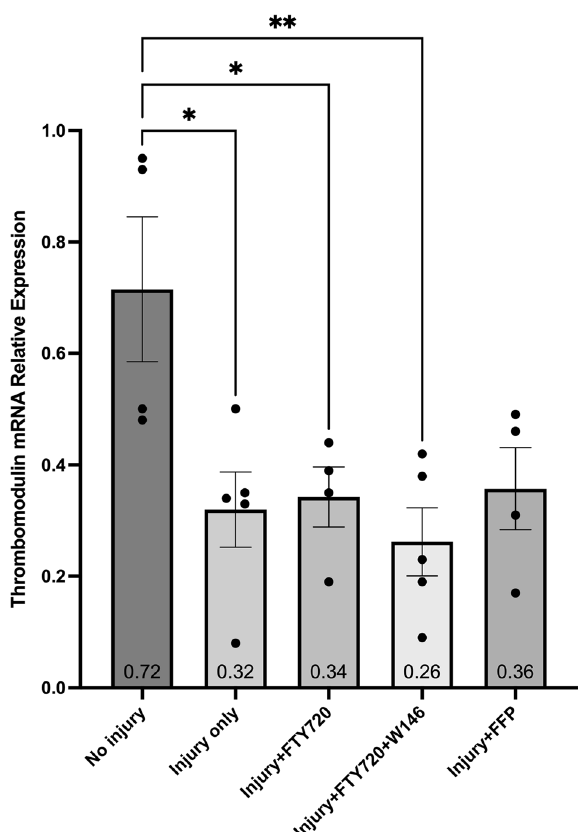
Fig. 5 Relative expression of thrombomodulin (TM) mRNA. The effect of treatment with FTY720, with and without 10 µ M of the sphingosine 1-phosphate receptor 1 (S1PR 1 ) antagonist W146, or fresh frozen plasma (FFP) on the relative expression of TM mRNA from injured cultured human umbilical vein endothelial cells (HUVECs). * p < 0.05, ** p < 0.01, N 5 for each =